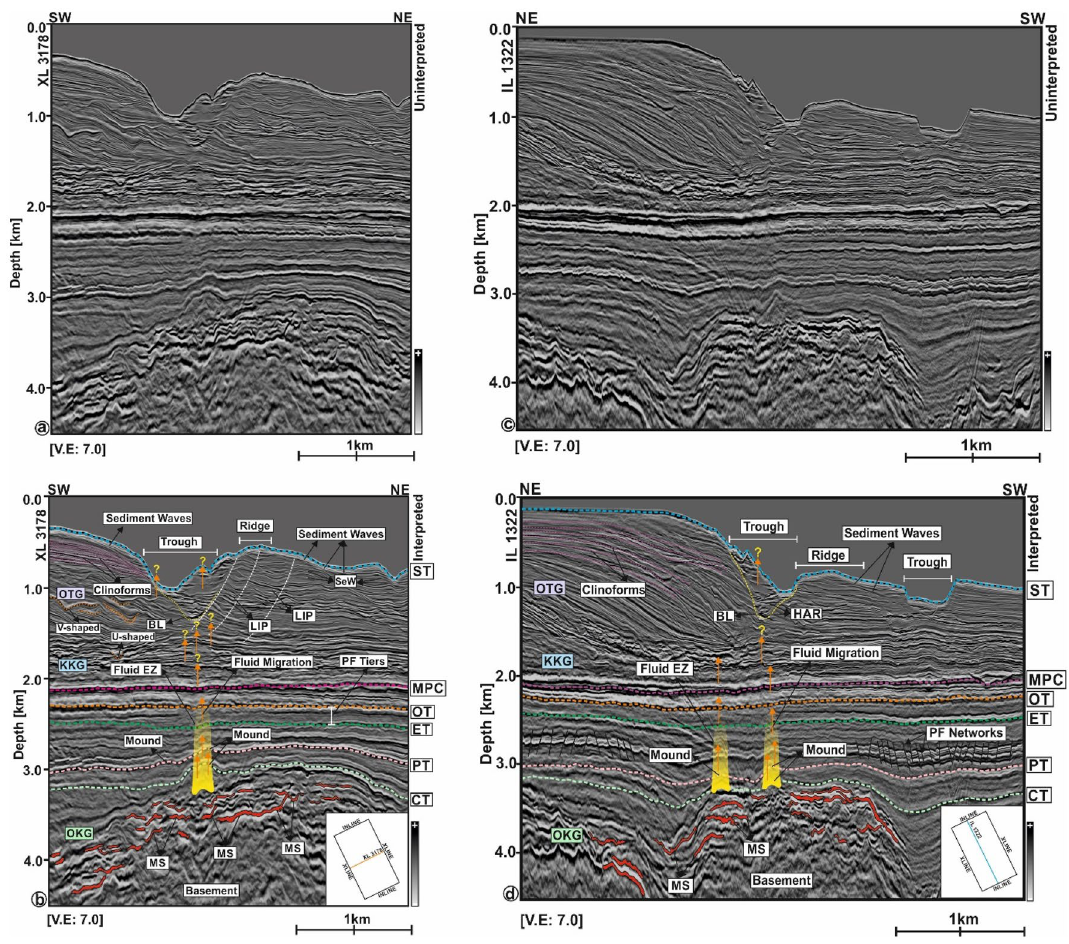
Figure 6. ( a – c ) Uninterpreted seismic lines XL 3178 and IL 1322 ( b – d ) corresponding interpretation on the subsurface structural framework of the Endurance 3D seismic survey. Subsurface strata mainly consists of three stratigraphy units: the Onekakara Group (OKG), the Kekenodon Group (KKG) and the Otakou Group (OTG). The zone of interest for this research is primarily focused on the seafloor and near seafloor strata (up to a depth of ~ 1200 m below the seafloor) into which fluids have migrated from the Cretaceous sediments through the KKG and the OTG. The seafloor is incised by the Waitaki Submarine Canyon, which is underlain by elongated clinoforms in its SW flank, basal lags at the canyon thalweg, clinoform packages, sediment waves, V- and U-shaped channel complexes and depressions over its northern banks. MS Magmatic Sill, CT Cretaceous Top, PT Paleocene Top, ET Eocene Top, OT Oligocene Top, MPC Marshall Paraconformity, ST Seabed Top, SeW Sediment Waves, EZ Escape Zone, LIP Laterally Inclined Package, BL Basal Lag, PF Polygonal